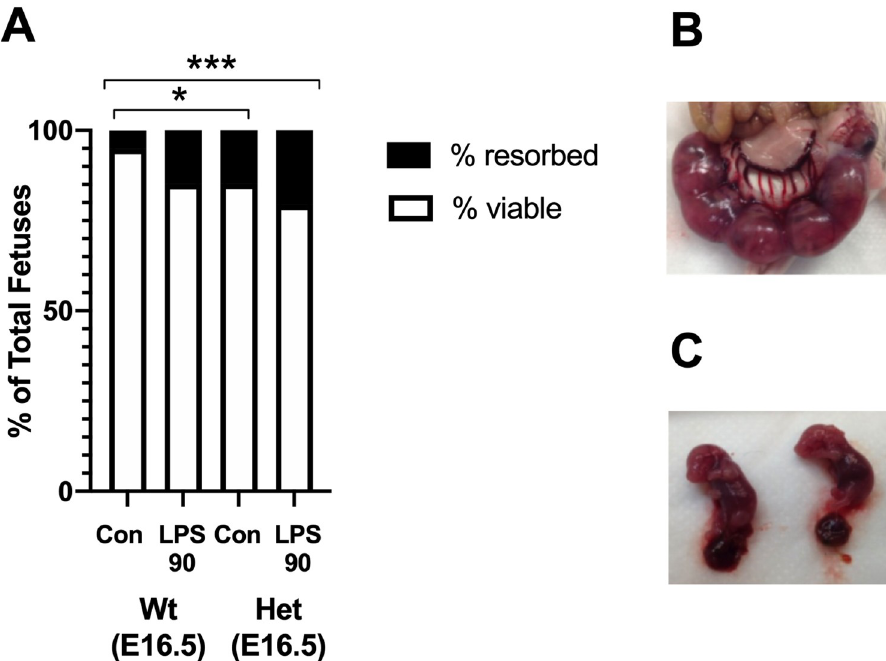
Fig 2. Fetal survival after LPS administration. ( A ) LPS at a dose of 90 ug/kg (LPS90) was administered i.p. to pregnant Wt or Het dams at E15.5 (control or Con, n = 9; LPS90, n = 8, sacrificed at E16.5). LPS90 was administered i. p. to pregnant- Het dams, at E15.5 (Con, n = 8; LPS90, n = 8, sacrificed at E16.5). Con were GA- and genotype- matched. For Wt, there was no significant decrease in percent live fetuses after LPS compared with genotype-matched controls. Fetal survival was significantly lower in untreated Het Con compared to untreated Wt Con at E16.5. Representative images taken 24 hrs after LPS90 administration of a ( B ) uterus and ( C ) fetuses from a Wt dam are shown. � p < 0.05, log-rank tests for viable versus